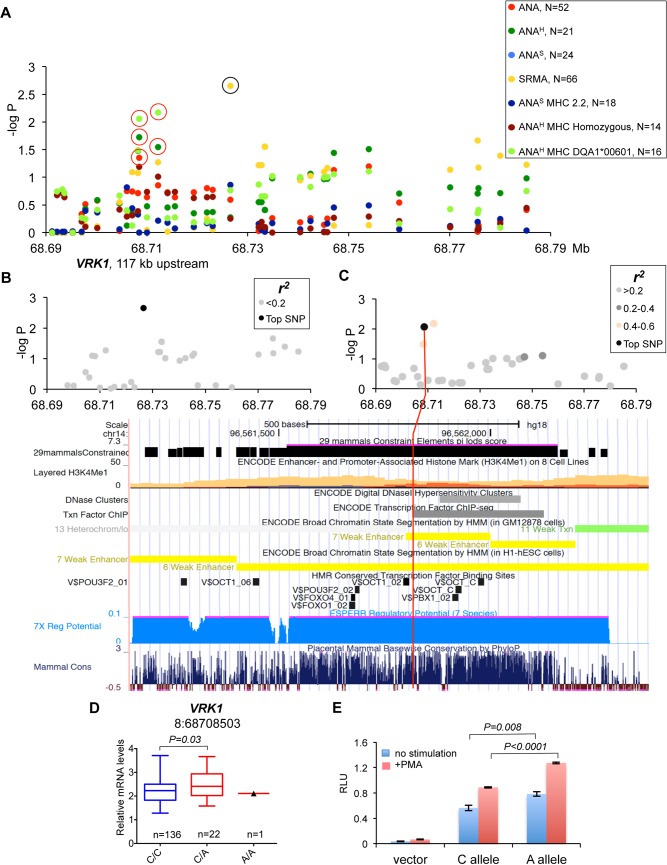
Genetic and gene expression analyses for chromosome 8 locus.
(A) Two independent strong association signals were observed for SRMA affected dogs (8:68726546) and ANAH dogs with DLA risk allele DLA-DQA1*00601(8:68712185 and 8:68708503). The only closest gene, VRK1, is located over 100 kb upstream of the associated region while there are no protein-coding genes for more than 1.9 Mb downstream. The black circle indicates the SRMA SNP not associated with expression changes of VRK1, the red circles—SNPs associated with VRK1 expression. (B) No SNPs were in LD with the top SRMA SNP. (C) The SNP 8:68708503 for ANAH dogs with DLA risk allele DLA-DQA1*00601 is not in LD with any other genotyped variants, but have a strong regulatory potential. The 1 kb region aligned with the corresponding human fragment is shown below with several tracks for gene regulation and conservation displayed. (D) Expression levels of the VRK1 gene in the blood cells of healthy NSDTRs stratified by SNP 8:68708503. Only one dog homozygous for the risk A allele was available. (E) The DNA fragment with the SNP 8:68708503 was cloned in the luciferase reporter vector and following transfection in K562 cells the protein lysate was assayed for enzyme activity. The risk allele A enhances luciferase expression comparing to the protective C allele in both unstimulated and stimulated with PMA cells.